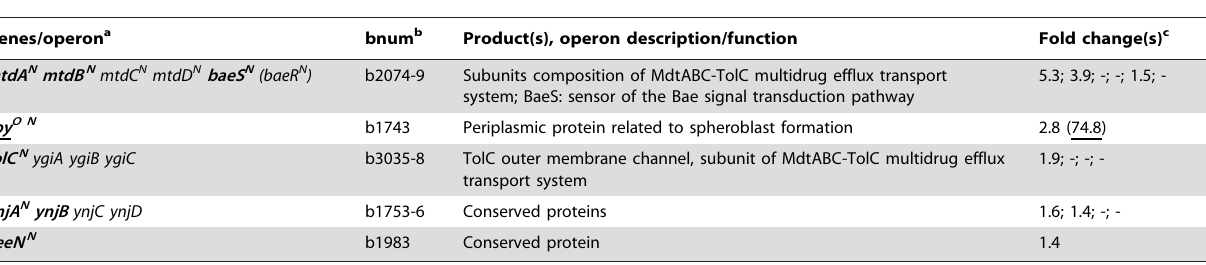
Table 4. Genes whose expression is significantly modulated by